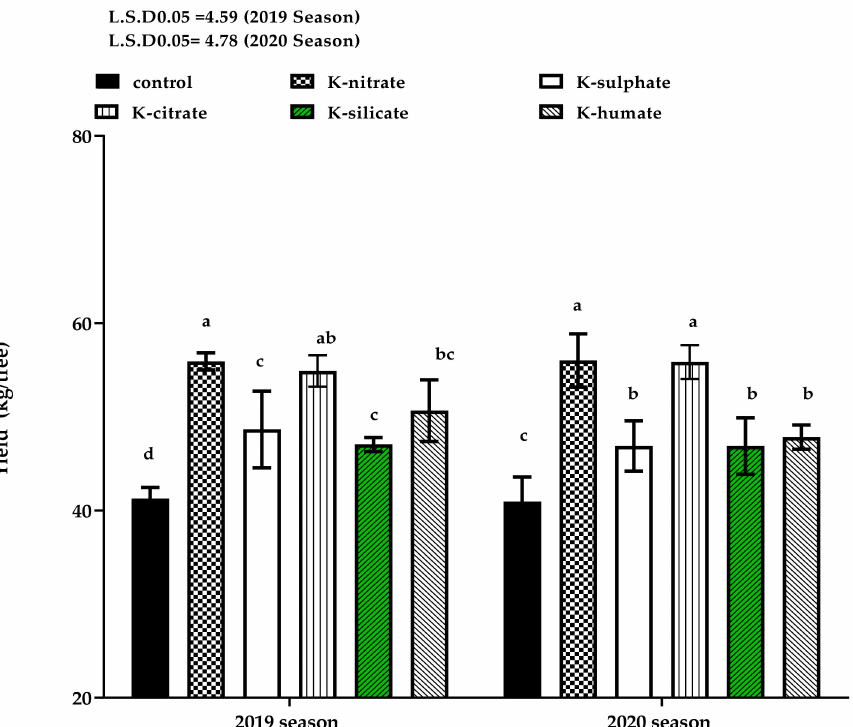
Figure 1. Effect of diverse potassium forms as foliar application on yield of apricot cv. ‘Canino’ in 2019 and 2020 seasons. Data represent the mean with SD. Letters above each bar shown the significant differences among the tested treatment, if letters were same corresponding treatments are statistically equal and vice versa according to Duncan’s multiple range tests at p <